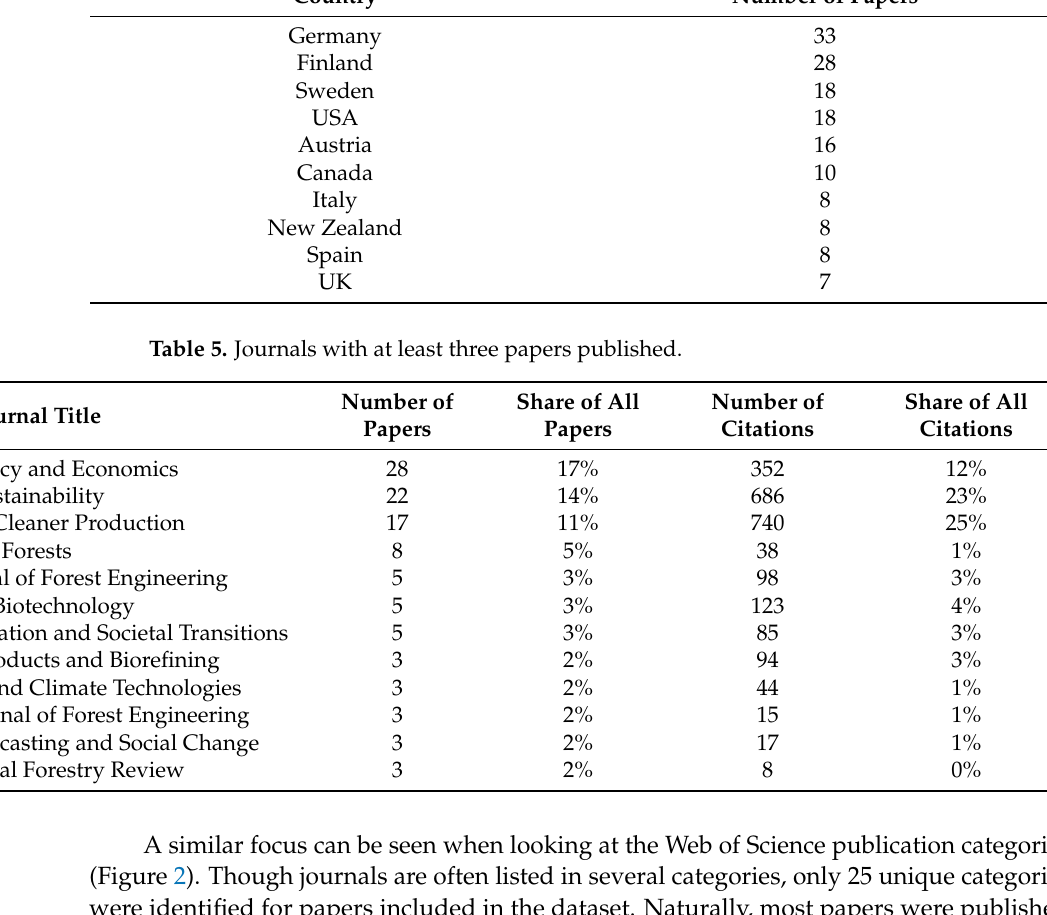
Table 4. The ten countries with the most authors of the papers included in the dataset. Country